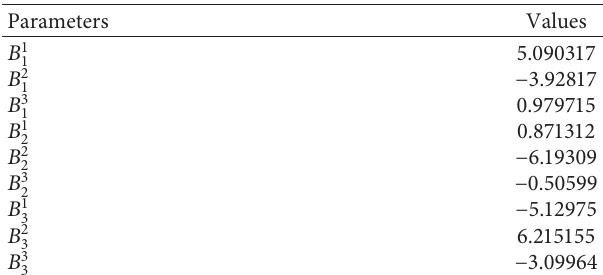
Table 3: Optimum values of the constant parameters related to the fuzzy rule